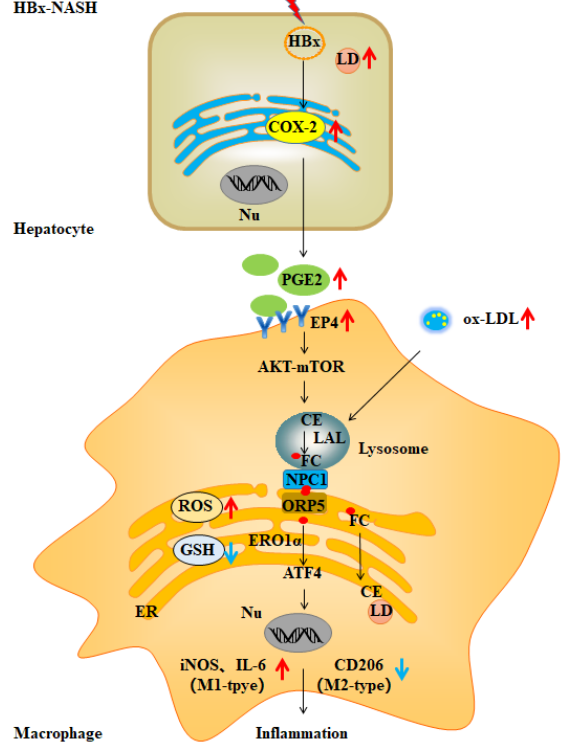
Figure 6. The mechanism of Lyso-ER cholesterol-transport-regulated macrophage polarization in HBx-related NASH. In HBx-induced ox-LDL-dependent NASH-associated inflammatory responses, the PGE2-EP4-mTOR signaling axis regulated NPC1-ORP5 interactions mediating Lyso-ER cholesterol transport. ER-redox-dependent ER stress induced by ER cholesterol is involved in mediating the M1 polarization of macrophages. The targeted intervention of EP4 rescues MC polarization imbalance to improve the NASH phenotype in HBx-Tg mice. The red arrows indicate the index was increased and the blue arrows indicate the index was decreased in this study.